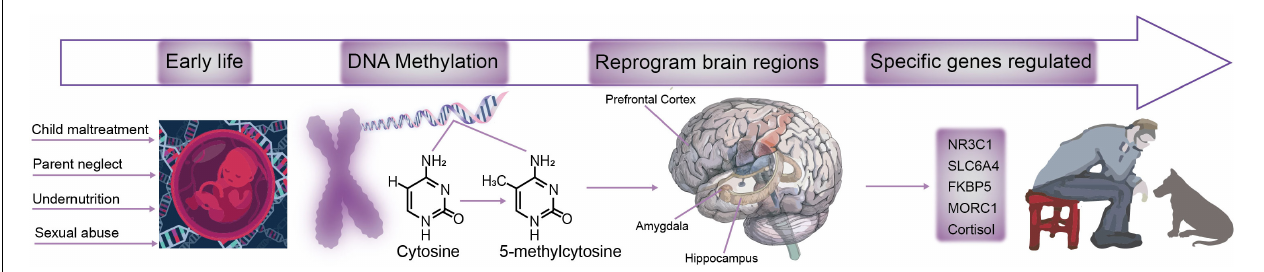
FIGURE 2 | A model for the mechanism of DAN methylation affects brain function. During development, the brain is sensitive to environmental changes, such as child maltreatment, parent neglect, less nutrition, or sexual abuse. ELS induces changes in the DNA methylation-5-methylcytosine pattern, which leads to brain damages in hippocampus, prefrontal cortex, amygdala and other brain regions are reprogrammed. As a result, specific genes such as NR3C1 , SLC6A4 , FKBP5 , MORC1 , and Cortisol are impaired, and ultimately lead to an increased risk of depression and other stress-related diseases.